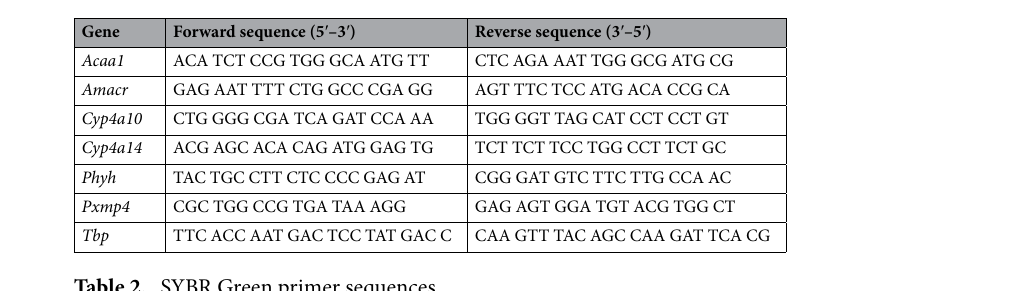
Table 2. SYBR Green primer sequences.